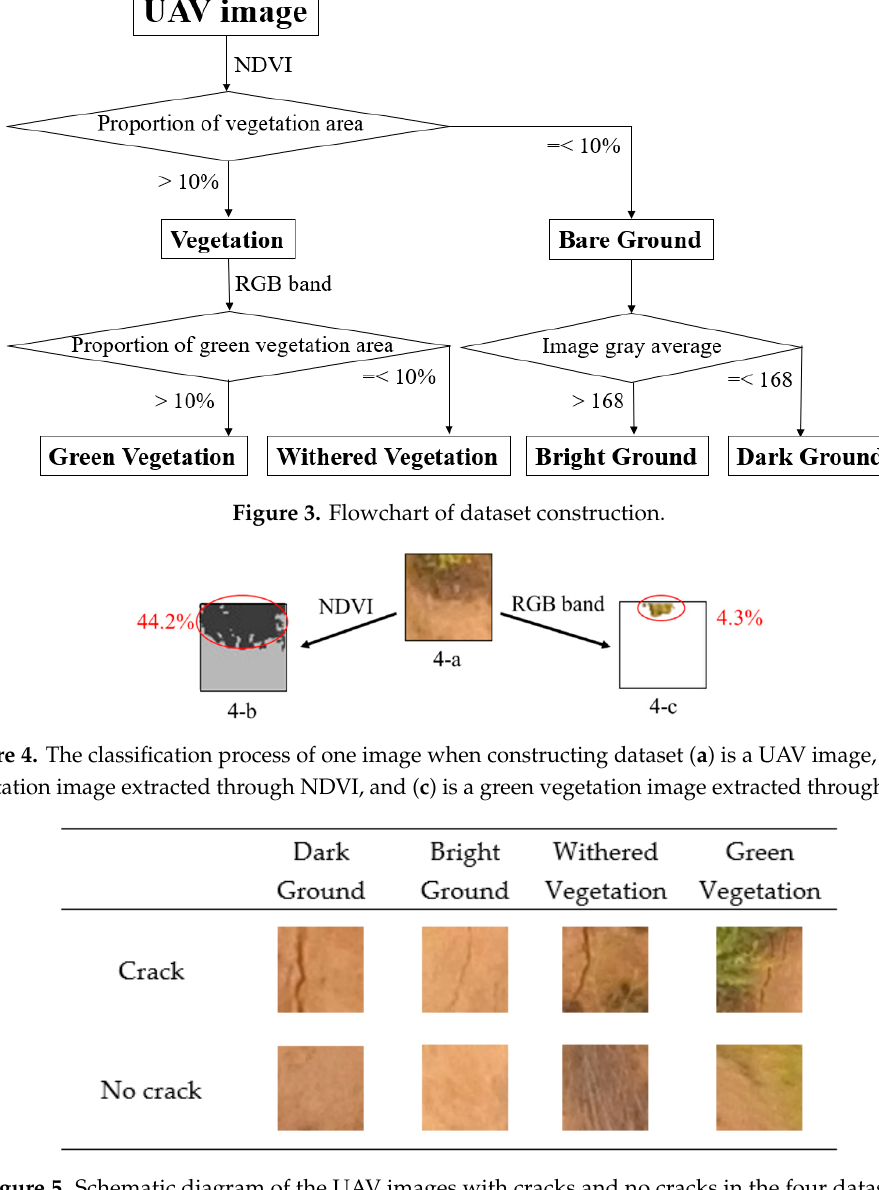
Figure 5. Schematic diagram of the UAV images with cracks and no cracks in the four datasets. Table 2. The number of training samples for the four datasets.